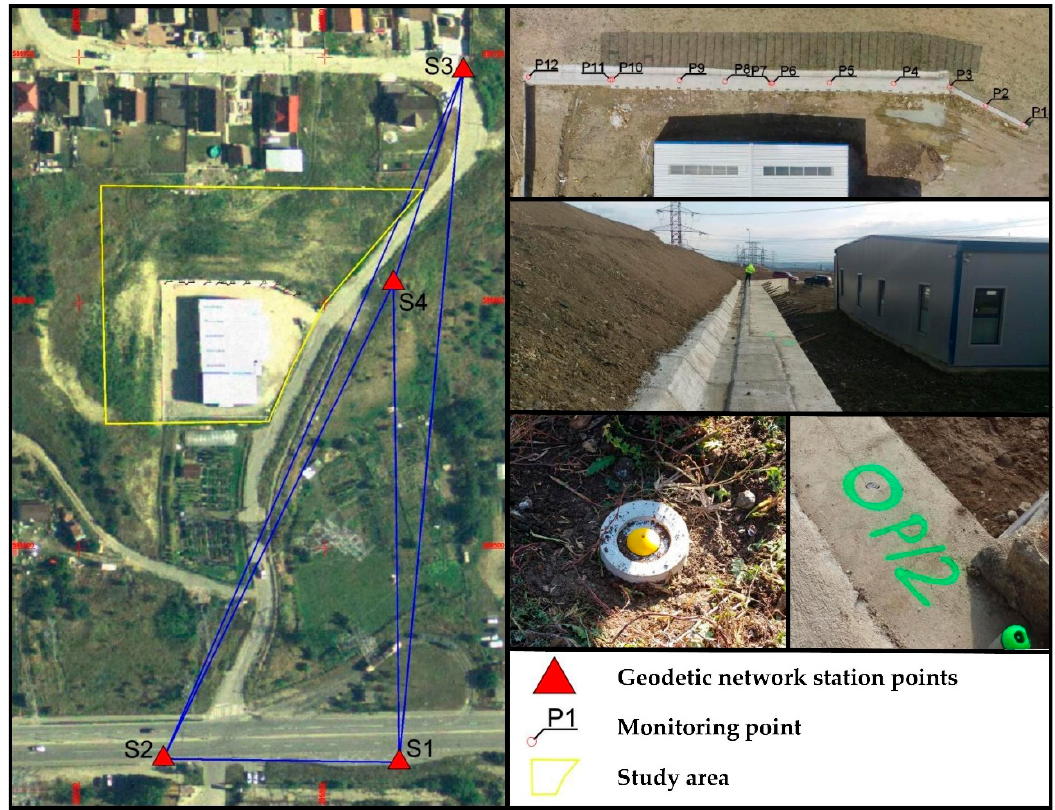
Figure 8. Established local geodetic network.